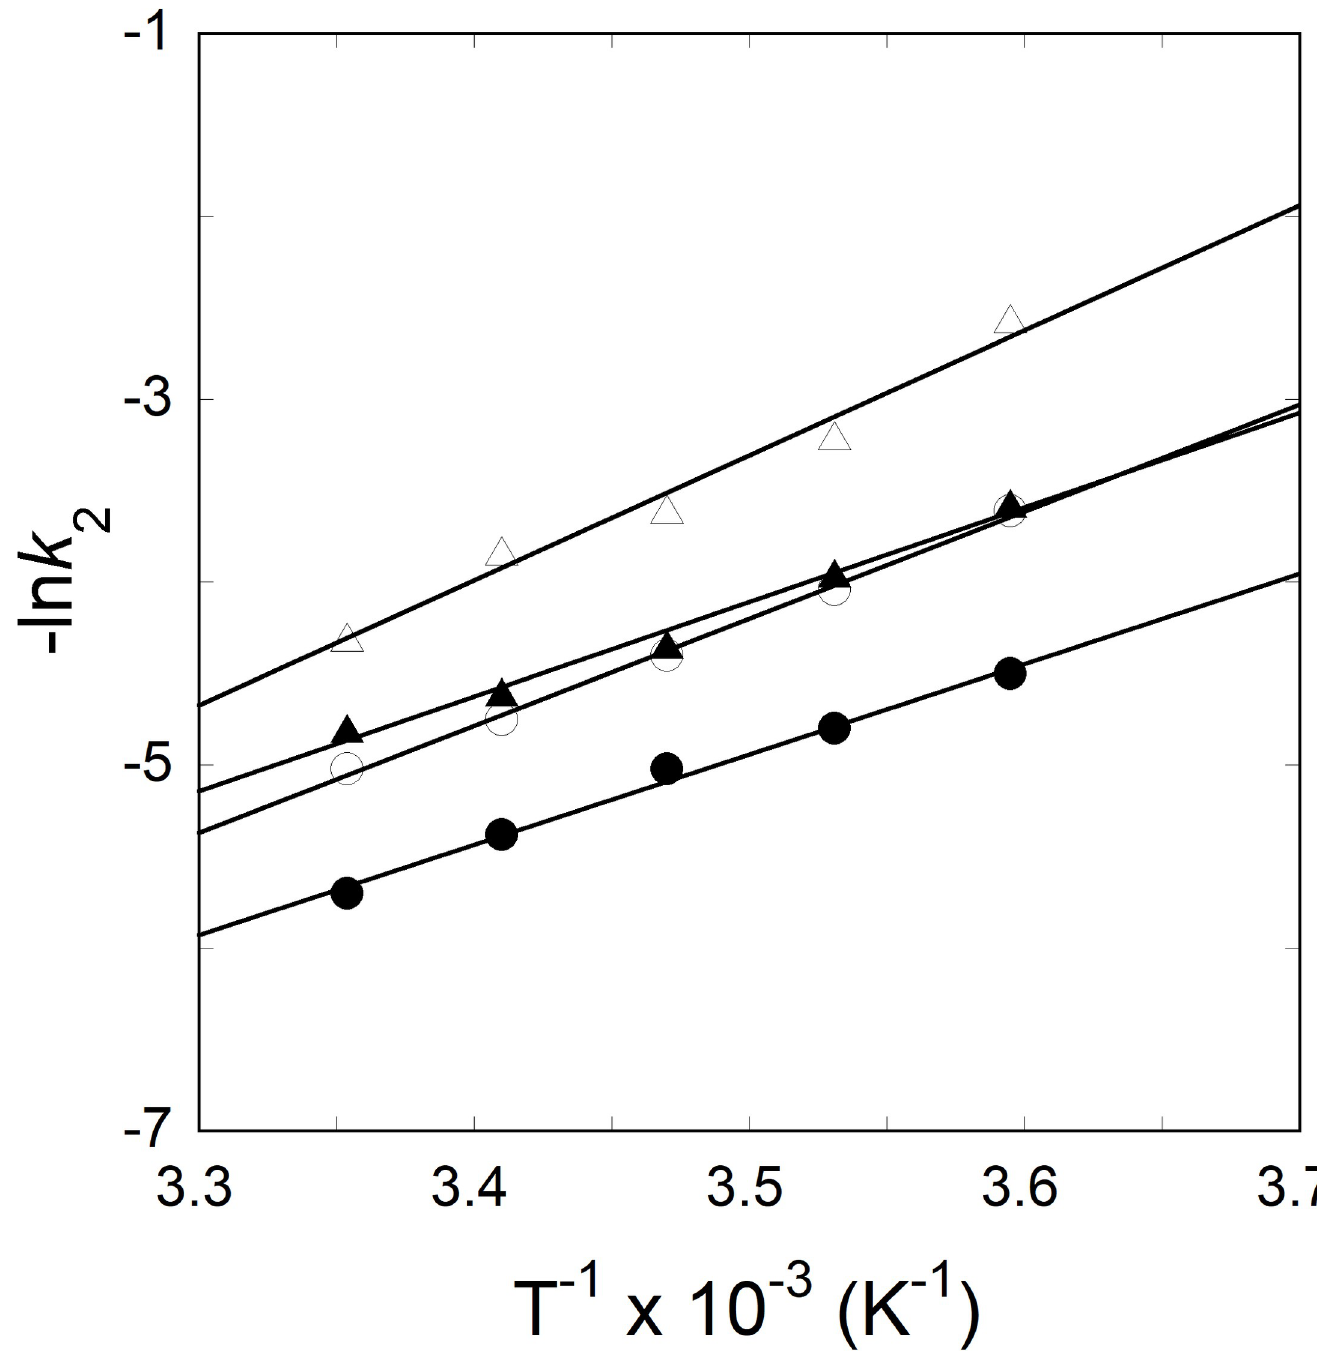
Fig 6. Arrhenius plots to determine the activation energies of the eIF4F � FRT IRE RNA and eIF4F � ACO2 IRE RNA interactions in the absence and presence of Fe 2+ . The observed rate constants for the interaction of eIF4F with FRT IRE RNA (—O—), FRT IRE RNA-Fe 2+ (— ● —), ACO2 IRE RNA (— Δ —), and ACO2 IRE RNA-Fe 2+ (— ▲ —). Concentrations of eIF4F, IRE RNA and Fe 2+ were 0.1 μ M, 1 μ M and 50 μ M, respectively, after reactants were mixed. The activation energy was calculated from the slope of the fitted linear plot of ln k versus 1/ T (Kelvin).